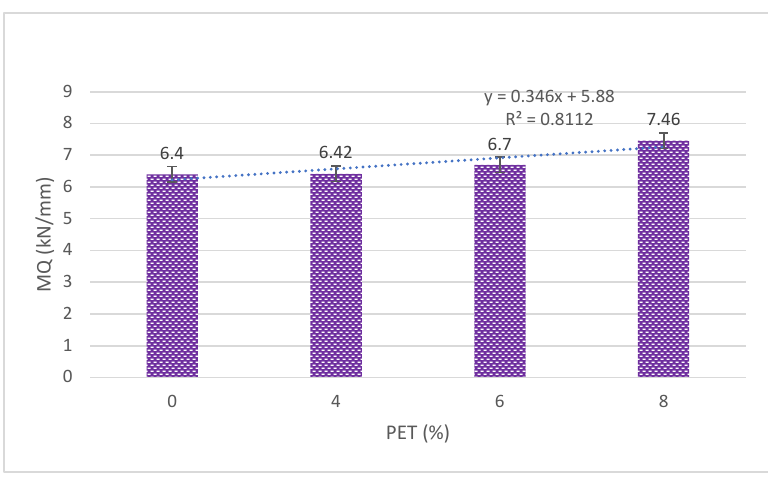
Figure 9. MQ results for the PET-modified SMA asphalt mixtures.